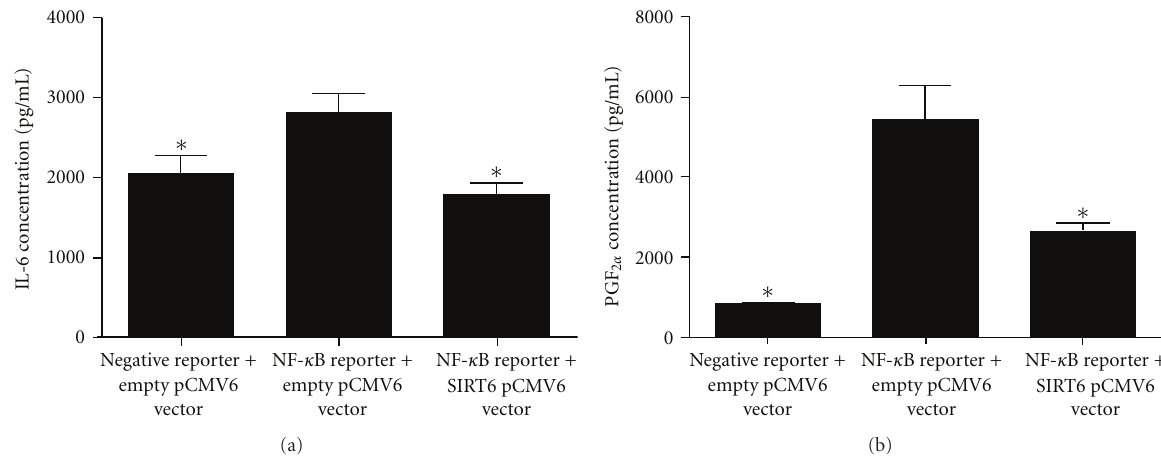
Figure 9: SIRT6 regulates proinflammatory mediators via NF- κ B. HUVECs were cotransfected with 1 μ g negative control construct and NF- κ B reporter construct, along with 1 μ g empty or SIRT6 pCMV6 vector for 72h. (a) IL-6 and (b) PGF 2 α , concentration in condition medium. Each bar represents the mean ± SEM ( n = 3 experiments). ∗ P < 0 . 05 versus cells transfected with NF- κ B reporter plus empty pCMV6